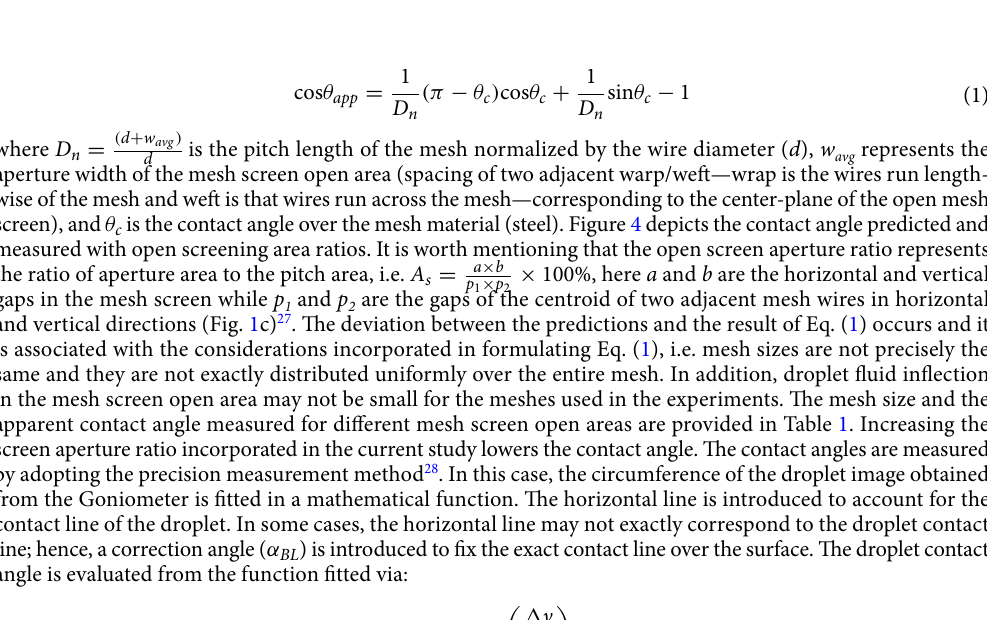
Fig. 5a and the local maxima of power sound level occurs at 75 Hz sonic excitation frequency. The effective flex- ural stiffness ( k